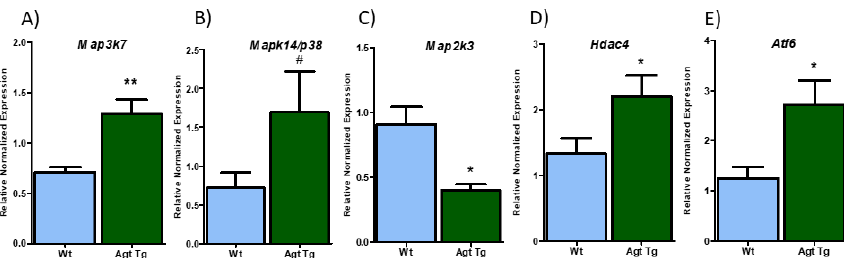
Figure 3. Renin–angiotensin system (RAS) overexpression differentially regulates genes related to inflammation and cell stress in mice epididymal white adipose tissue (WAT). ( A , B ) RAS overexpression induces mitogen-activated protein kinase kinase kinase 7 ( Map3k7 ) and mitogen activated protein kinase 14 ( Mapk14/p38 ) expression compared to wild type (Wt) mice. ( C ) However, RAS overexpression significantly downregulated mitogen activated protein kinase kinase 3 ( Map2k3 ) expression in Agt Tg compared to Wt mice. ( D , E ) Similar to Map3k7 , histone deacetylase 4 ( Hdac4 ) and activating transcription factor 6 ( Atf6 ) were upregulated in Agt Tg group compared wild-type (Wt) mice WAT. Data are presented as mean ± SEM ( n = 8). (** p < 0.001, * p < 0.05, # p <